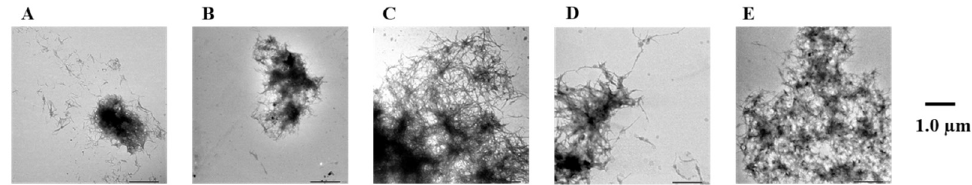
Figure 7. Efficacy of compounds 1 , 3 , 7 , and 8 against pre-existing A β 42 aggregates visualized by use of TEM. Scale bars: 1.0 μ m. ( A ) A β 42 + 1 , ( B ) A β 42 + 3 , ( C ) A β 42 + 7 , ( D ) A β 42 + 8 , and ( E ) A β 42.